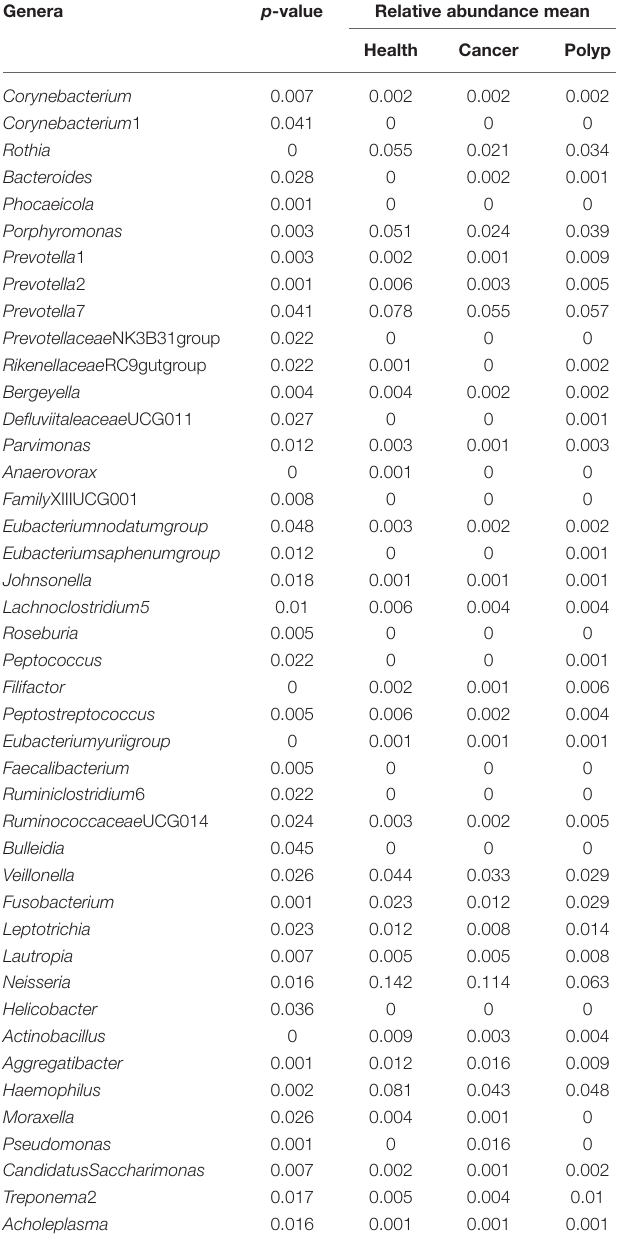
TABLE 1 | The difference in abundance for each bacterial taxon in samples from the throat cancer patients, vocal cord polyp patients, and normal control group. Genera p